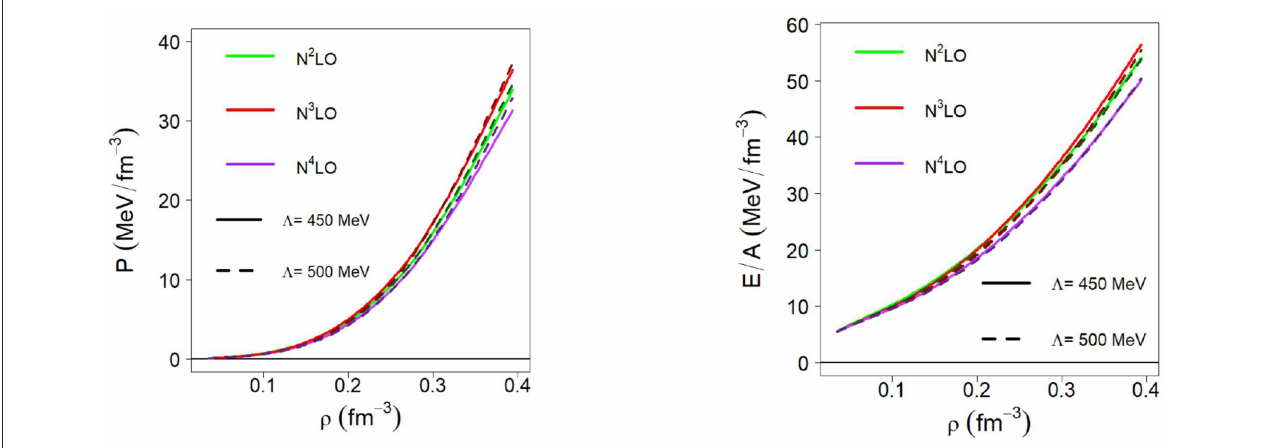
FIGURE 11 | (Left) pressure in β -equilibrated matter vs. density at the given chiral orders (of the NM chiral EoS). Predictions with both cutoffs are shown, revealing that the two sets of curves are very similar. (Right) the corresponding energy per particle. These are the predictions which we retain up to 2 ρ 0